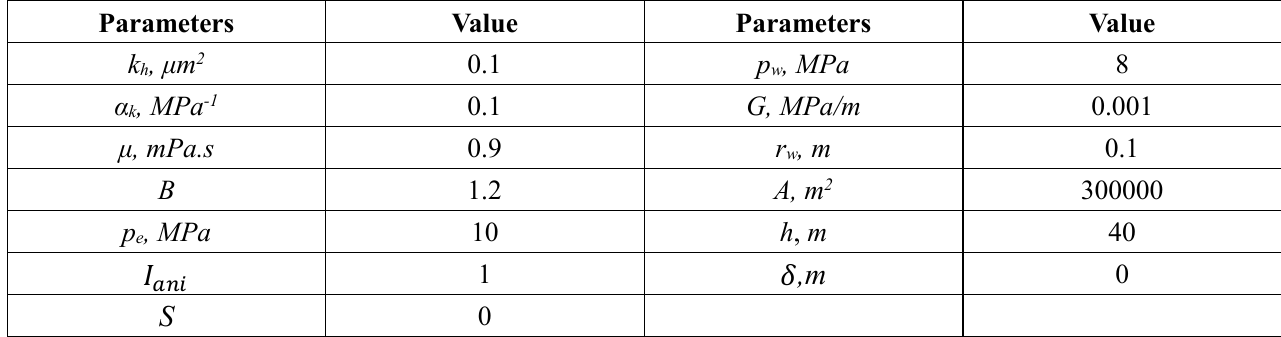
Table 1—Basic data used in the calculation